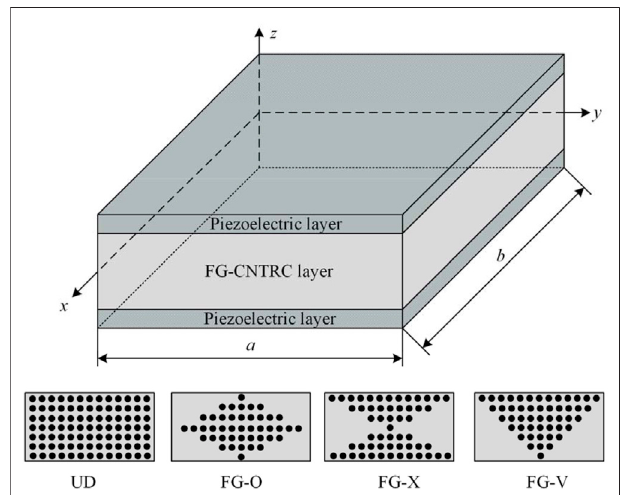
FIGURE 1 | Con fi guration of the rectangular FG-CNTRC plate with piezoelectric